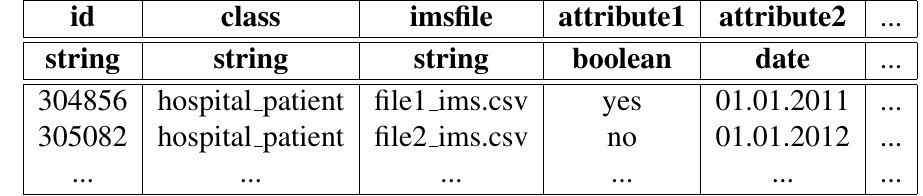
Table 1: This table illustrates the structure of the object-attribute-table. The first two rows com- prise identifiers and attribute names with corresponding data types in the second row.